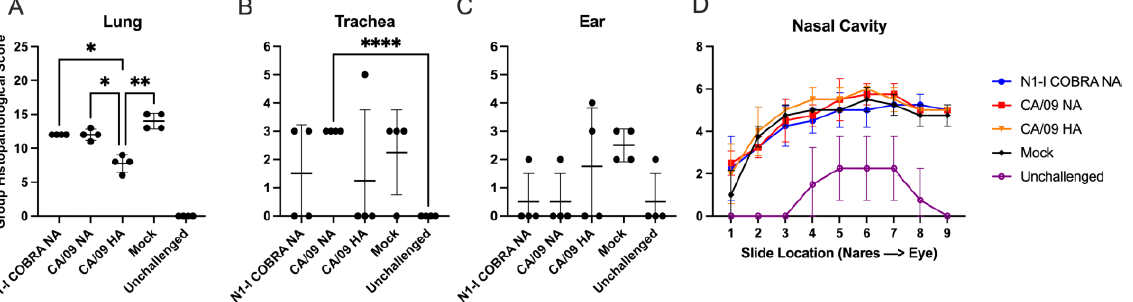
Figure 3. N1-I COBRA NA vaccine induced similar inflammation in the upper and lower respiratory tract as the CA/09 HA and CA/09 NA vaccines in naïve ferret model after intranasal infection with CA/09 H1N1. H&E-stained formalin-fixed and embedded tissues were scored for the severity and distribution of inflammation. ( A ) The NA-based vaccines had the same mean severity score and were significantly greater than the CA/09 HA vaccine group. All groups were significantly different ( p < 0.01) compared to the unchallenged group (not shown). ( B ) The trachea was examined for inflammation and the CA/09 NA-vaccinated group had higher incidence and mean severity scores compared to all other groups. ( C ) The inflammation in the middle and inner ear was mild. The mock group had 100% incidence. ( D ) Sections of the nasal cavity from the nares to the eye were examined for inflammation. All challenged animals had similar group histopathological scores compared to the unchallenged group, in which the histopathological score was representative of background, non-significant inflammatory cellular infiltrates. A two-way repeated measures ANOVA with Tukey’s test for multiple comparisons was used for statistical analysis of the lung, trachea, and ear sections, and the same analysis conducted separately for the nasal cavity sections. Adjusted p -value: * ≤ 0.05, ** ≤ 0.01, **** ≤ 0.0001.